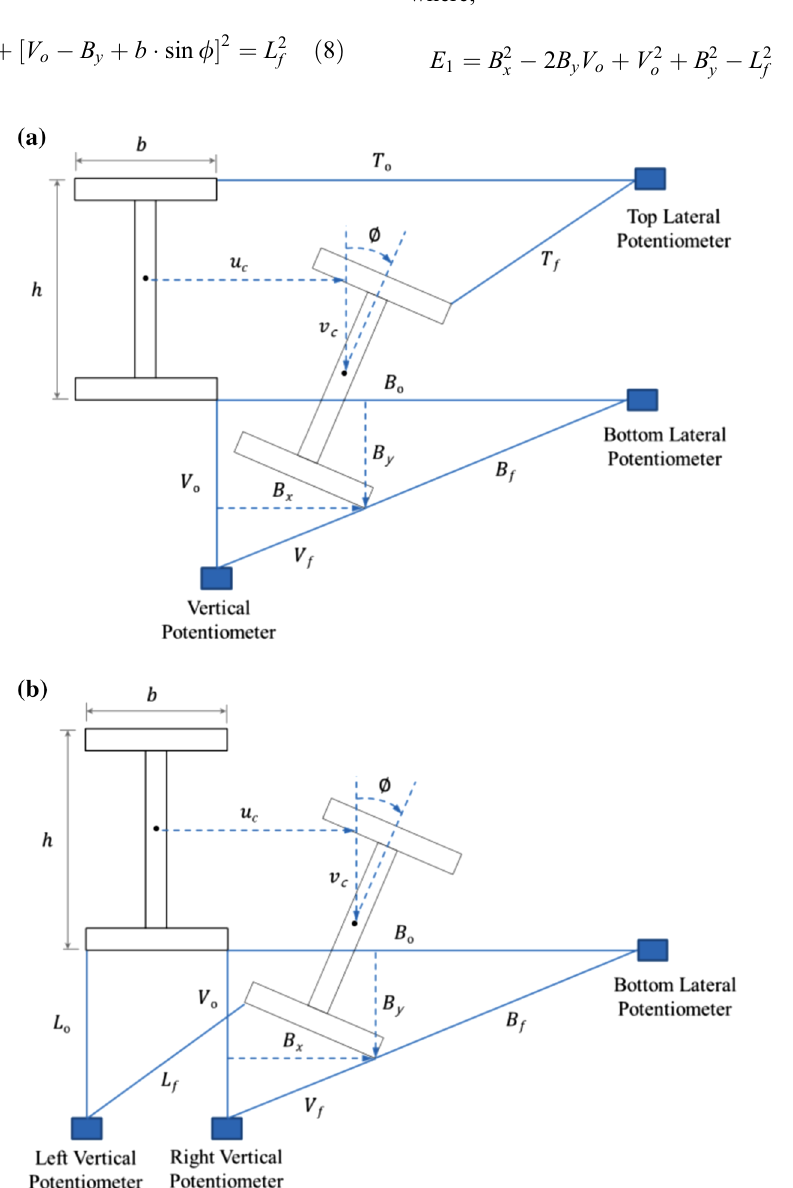
Fig. 7 Configurations of the potentiometers before and after deformation of the beam using a two lateral potentiometers and b two vertical